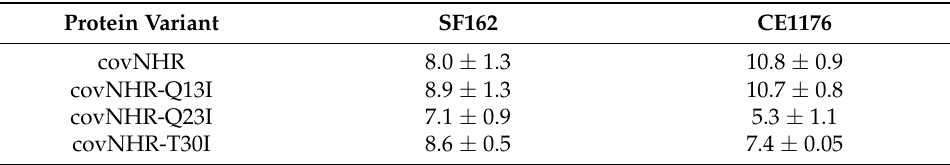
Table 2. HIV-1 inhibition activity of covNHR proteins measured with the standard TZM-bl assay using SF162 (subtype B) and CE1176 (subtype C) pseudoviruses. Values correspond to IC50 in nM